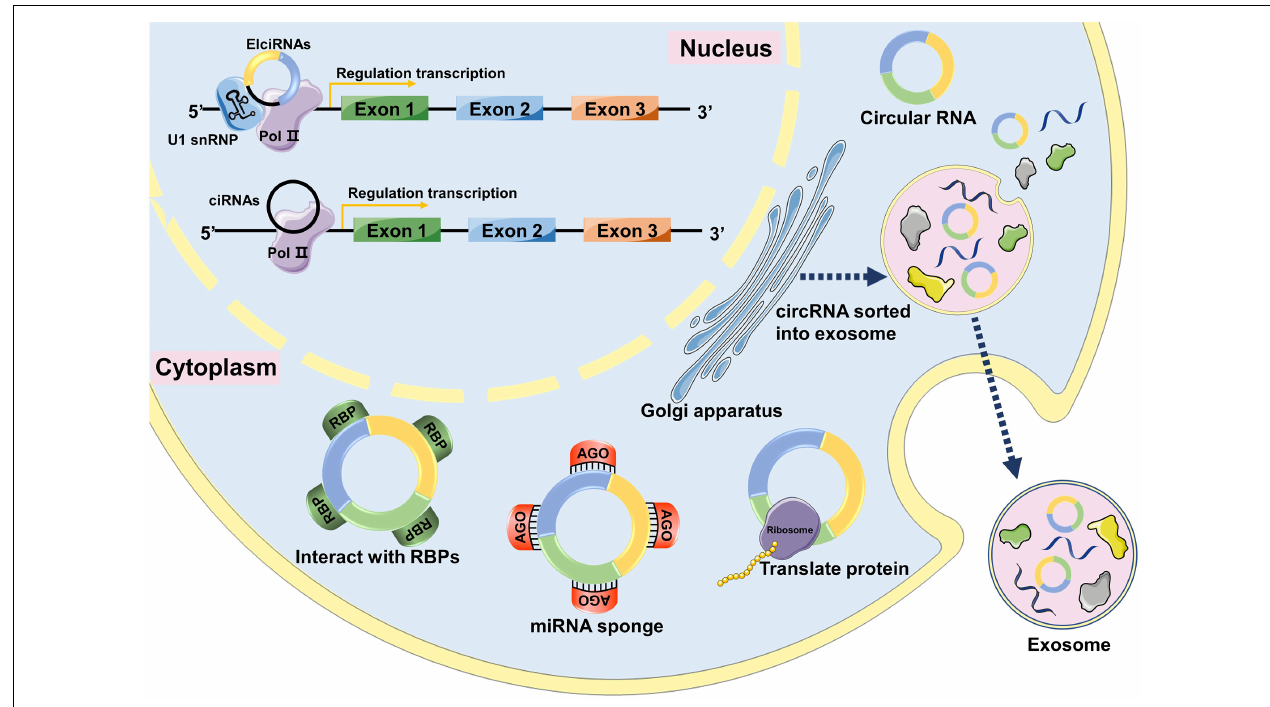
FIGURE 1 | The functions of circRNAs. In the nucleus, circRNAs can interact with transcription complexes in the promoter region of their host gene to induce gene transcription by interacting with U1 snRNP. circRNAs can directly interact with transcription complexes on host genes to induce their transcription. In the cytoplasm, circRNAs can interact with RBPs and affect their functions and translocations. circRNAs can act as miRNA sponges to inhibit miRNA activity by interacting with miRNA-Ago2 complexes. Some circRNAs have protein-coding capacity and can encode proteins. circRNAs can be loaded into exosomes, released by donor cells, and enter recipient cells through endocytosis, thus modulating gene expression in recipient